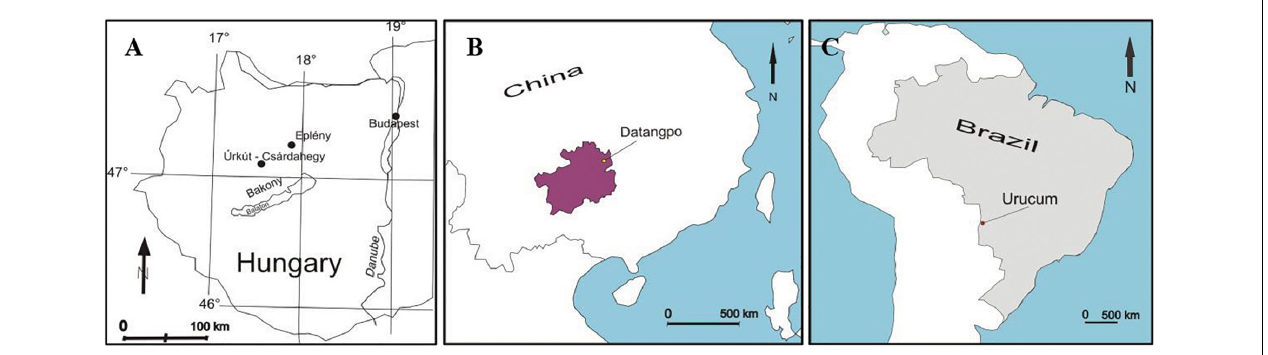
FIGURE 1 | Localities of Mn deposits considered for comparison. (A) Úrkút, Hungary. (B) Datangpo, China. (C) Urucum,